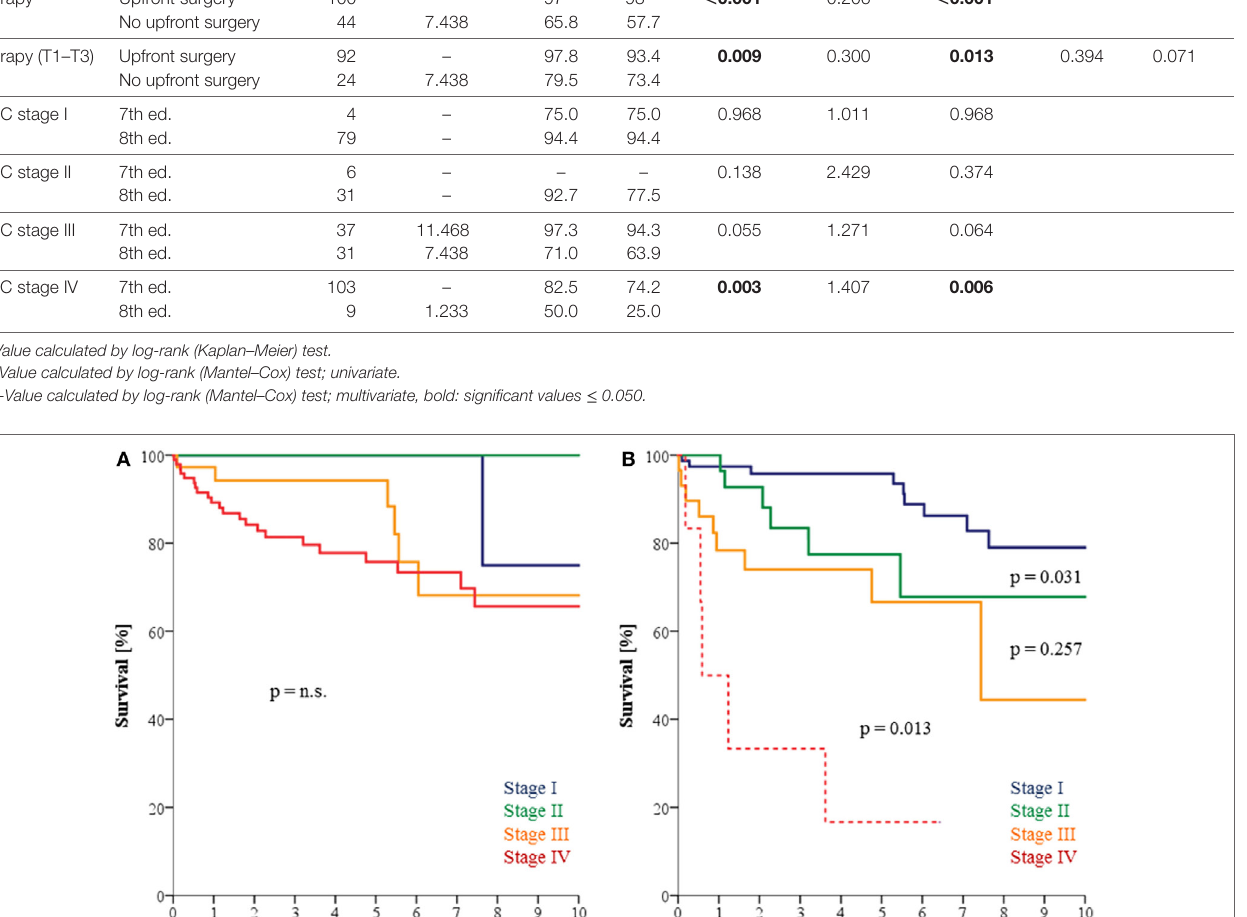
Frontiers in Oncology | www.frontiersin.org